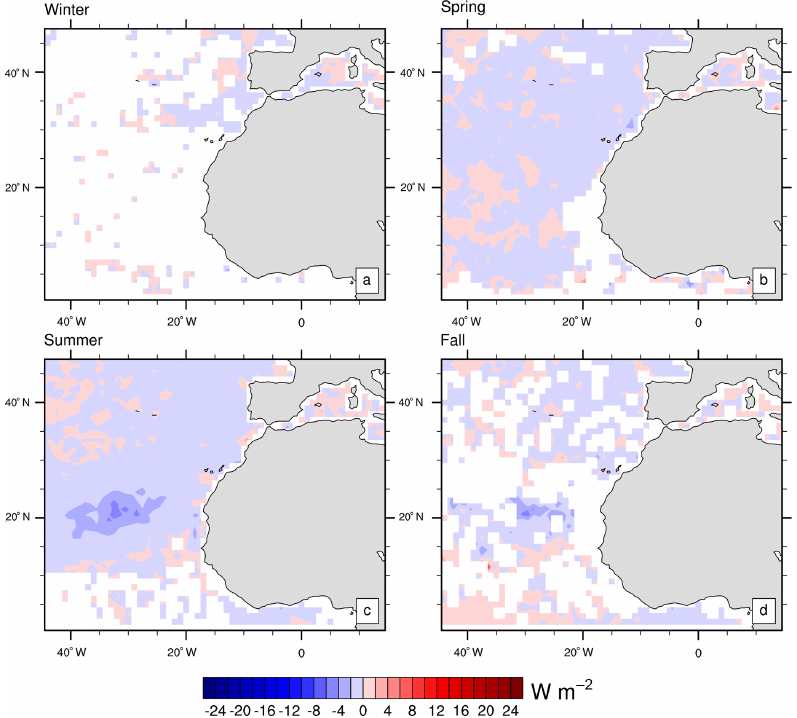
Figure 7. The extrinsic aerosol–cloud radiative effect (Wm − 2 ) following Chen et al. (2014) for (a) winter, (b) spring, (c) summer, and (d)